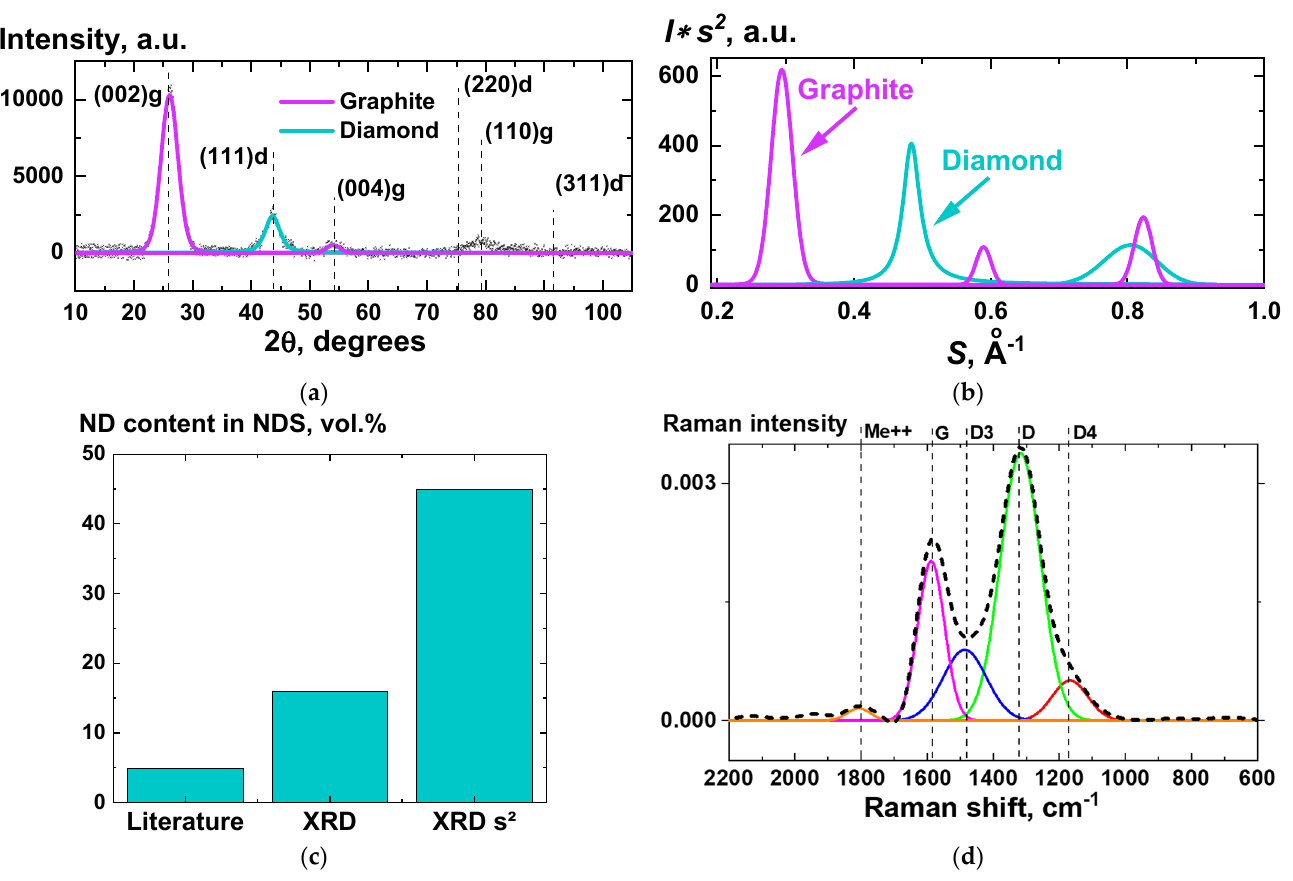
Figure 4. ( a , b )—XRD patterns without ( a ) and with ( b ) implementation of Ruland’s method [29]; ( c )—results of estimation of ND in NDS content value from XRD patterns without (“XRD”) and with implementation of Ruland’s method (“XRD s2”), and also the value provided by the manufacturer [11] (“Literature”); ( d )—Raman spectroscopy results for NDS powder. Dotted line ( a , d ) represents the obtained experimental data, solid lines ( a , b , d )—peaks from decomposition of the experimental data. Dashed vertical lines ( a , d ) indicate the centers of the peaks.